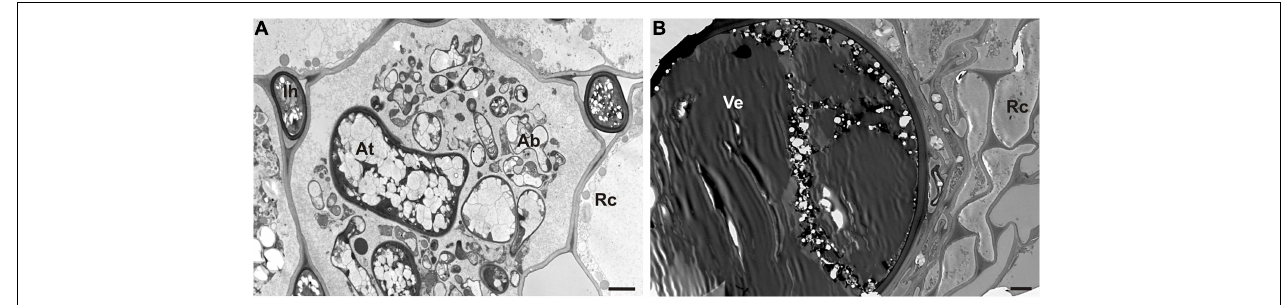
FIGURE 5 | TEM micrographs of symbiotic mycorrhizal fungi in roots of nodulated T. repens from the metal-polluted waste heap area. (A) Arbuscule (Ab) and intercellular hyphae (Ih) of arbuscular mycorrhiza fungi in root cortex cells (Rc). At, arbuscule trunk. (B) Visible large vesicle (Ve) inside root cortex cells (Rc). Scale bars correspond to 2 µ m.